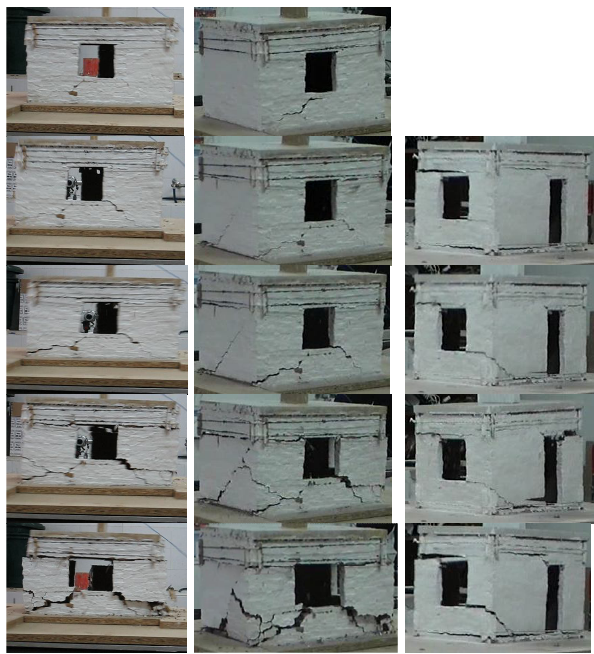
Fig. 26 Failure sequence of specimen P3